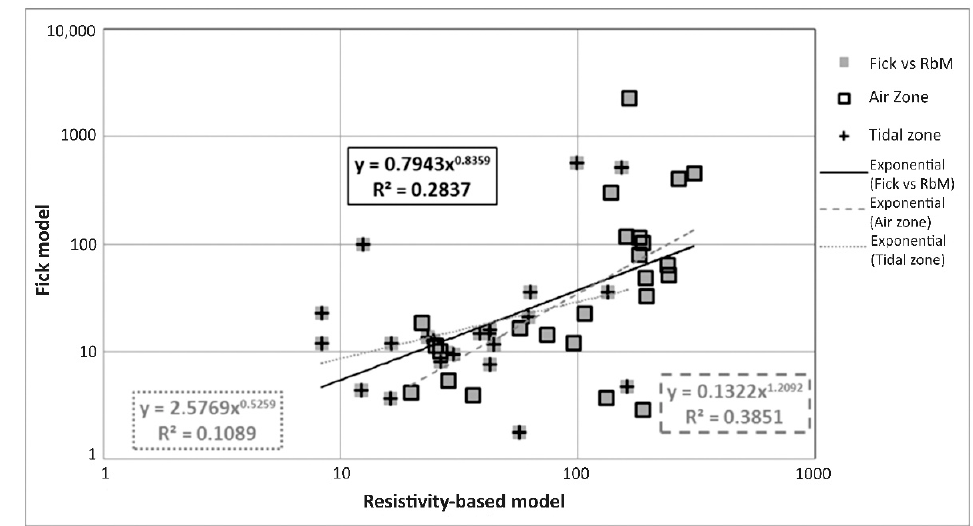
Figure 10. Fick’s model vs. Resistivity-based model (RbM) and exhibition zones.